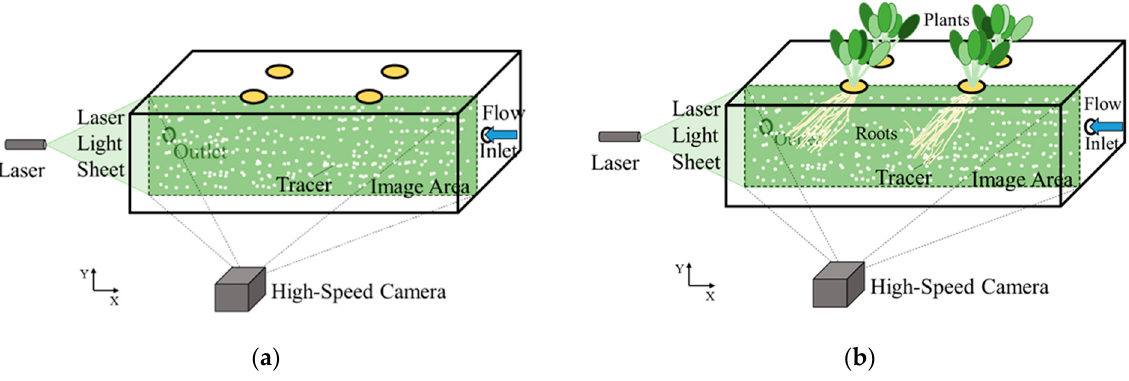
Figure 3. Observation method of the flow field and roots in hydroponics: ( a ) without plants; ( b ) with plants.